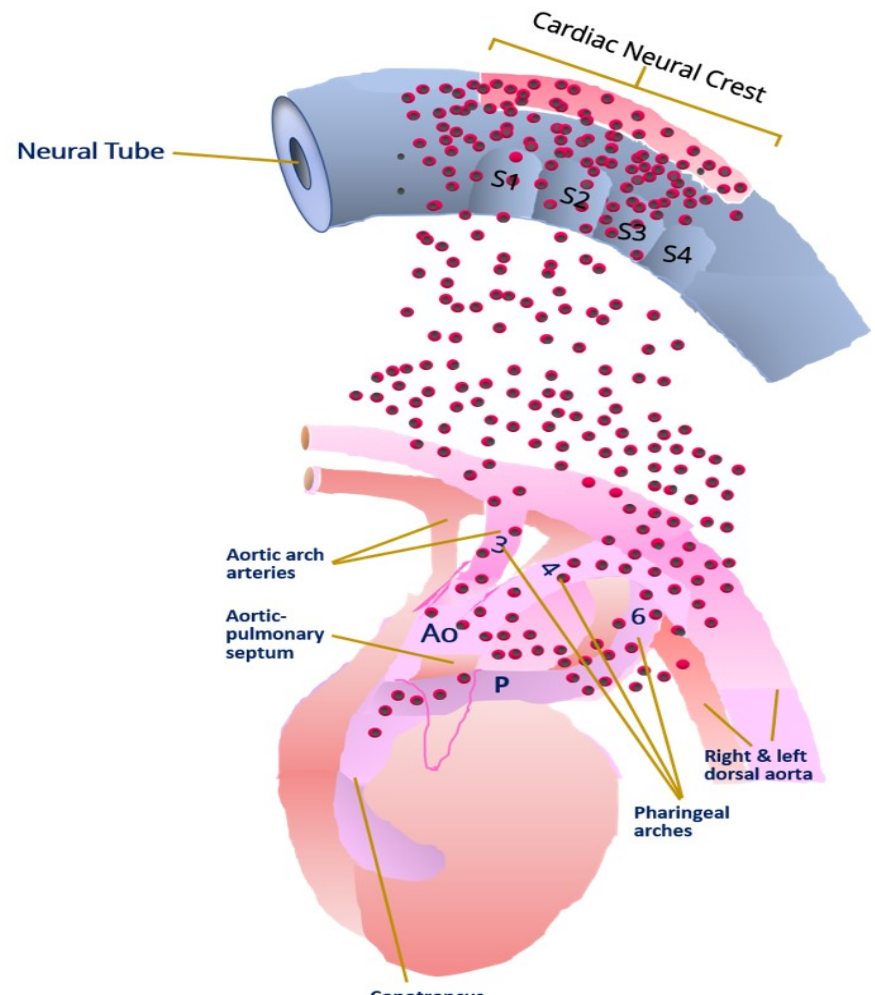
Figure 3. Graphic representation of the migration of the cardiac neural crest cells to the caudal pharyngeal arches and aorticopulmonary septum before remodeling of the aortic arch arteries and vascular regression. In 45,X embryos, when the delayed cell cycle results in a migratory reduction of cardiac neuronal cell proliferation, abnormal remodeling of the aortic arch arteries and/or vascular regression could originate as a subsequent consequence. Abbreviations: Ao, aorta; P, pulmonary artery; S1, S2, S3, and S4, somites 1–4; 3, 4, and 6, 3rd, 4th, and 6th pharyngeal arches.